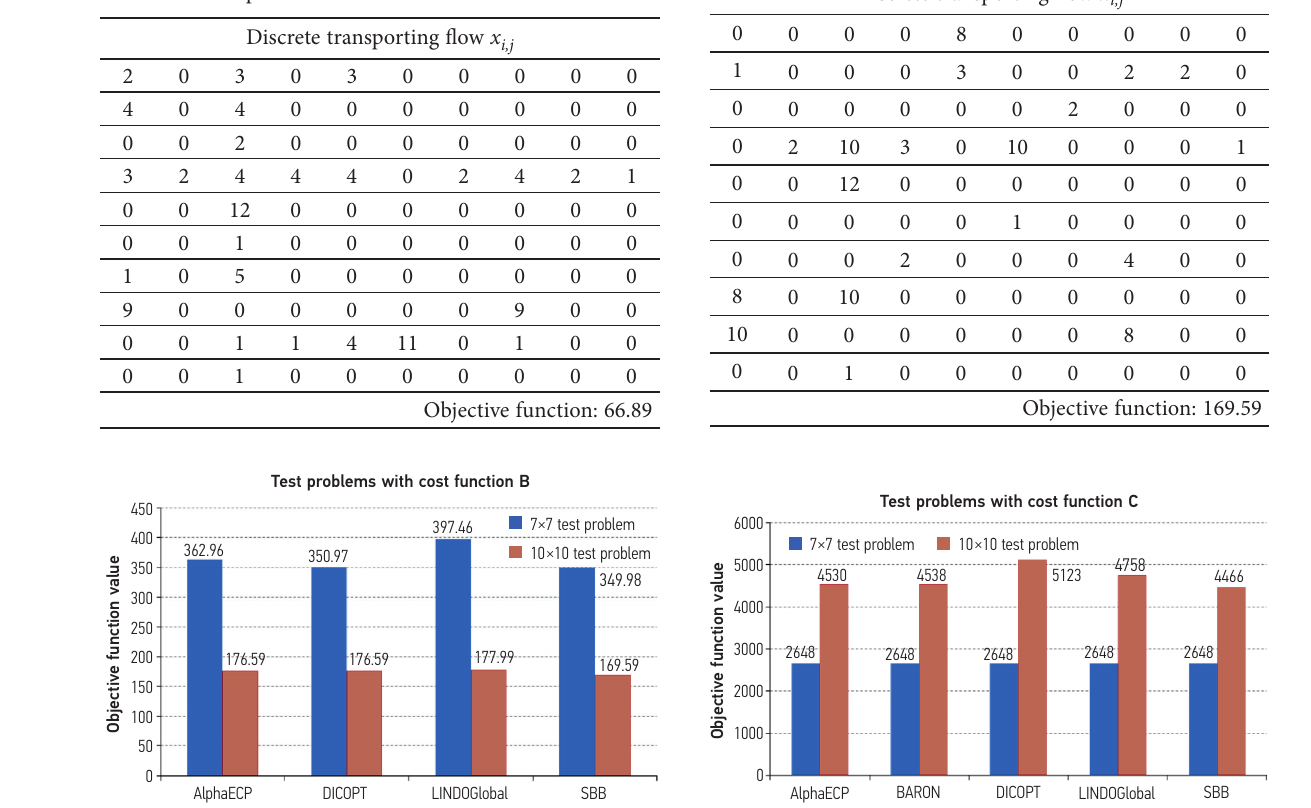
Fig. 4. Objective function values for test problems with cost function C